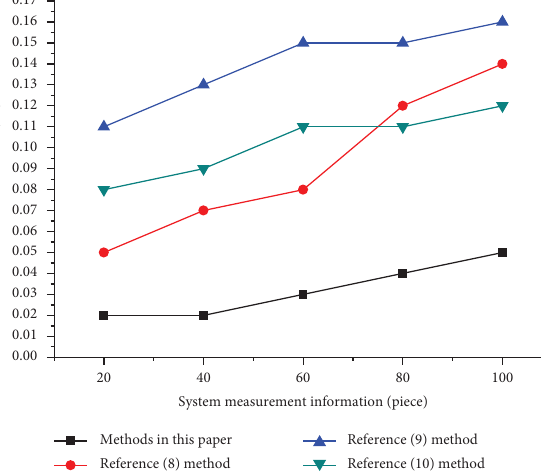
Figure 8: Identifcation time consuming